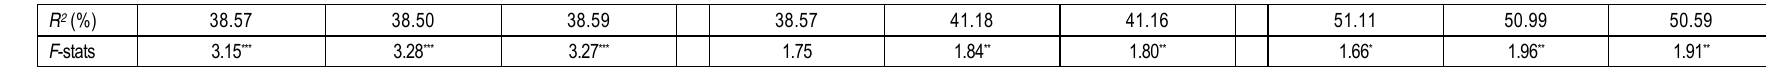
Table 6. (cont.). OLS Estimates-Robust and Bootstrap Standard Errors (MAIR)